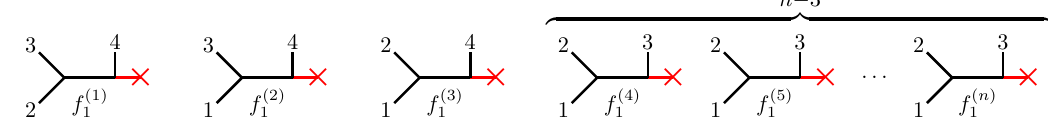
Figure 5 . Subtrees defined by the internal edge f ( i ) represented with a red